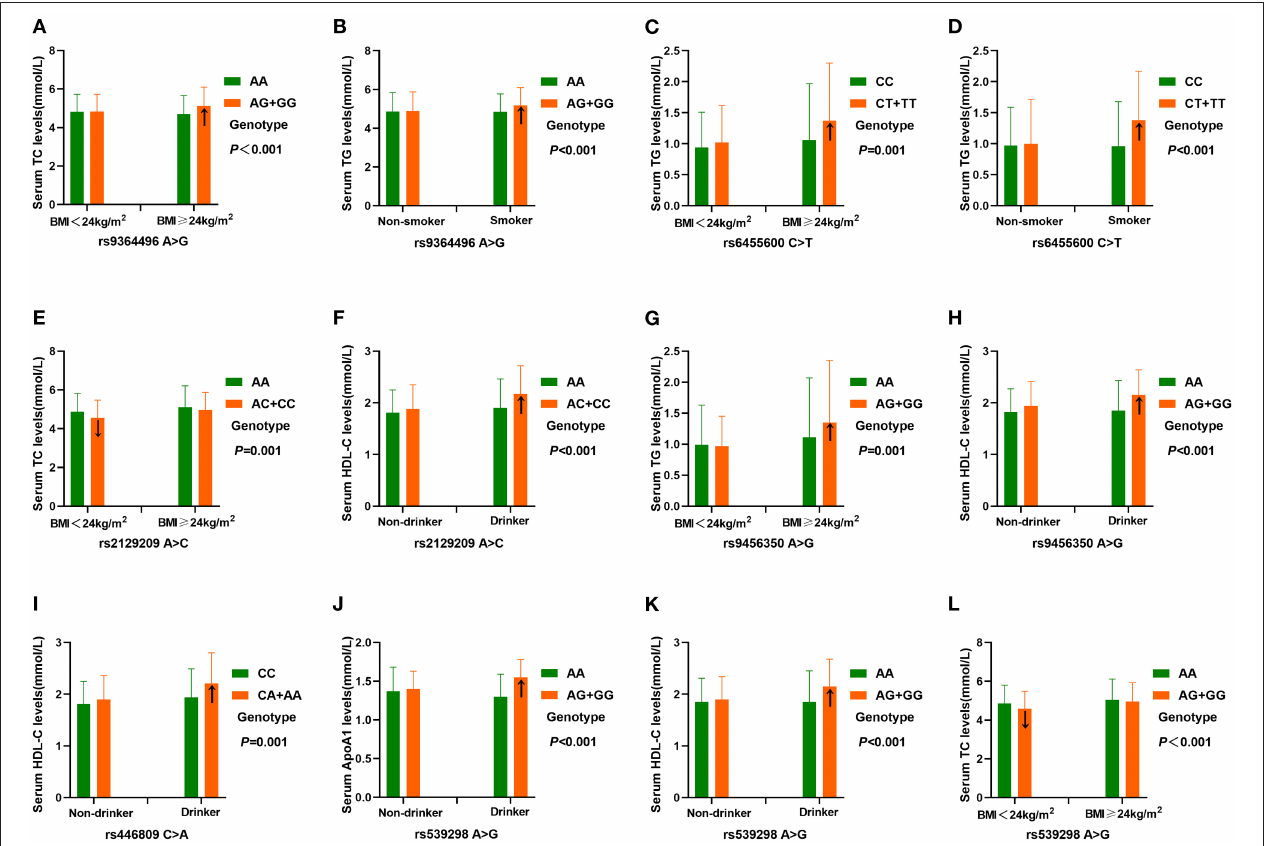
FIGURE 5 | The interactions of the SYTL3 - SLC22A3 SNPs and drinking, BMI and smoking on serum lipid levels. TC, total cholesterol; TG, triglyceride; BMI, body mass index; ApoA1, apolipoprotein A1; HDL-C, high-density lipoprotein cholesterol. A P ≤ 0.00125 (corresponding to P < 0.05 after adjusting for five environmental exposures multiplied by eight outcomes by the Bonferroni correction) was considered statistically significant. (A) , rs9364496-BMI on TC; (B) , rs9364496-smoking on TG; (C) , rs6455600-BMI on TG; (D) , rs6455600-smoking on TG; (E) , rs2129209-BMI on TC; (F) , rs2129209-drinking on HDL-C; (G) , rs9456350-BMI on TG; (H) , rs9456350-drinking on HDL-C; (I) , rs446809-drinking on HDL-C; (J) , rs539298-drinking on ApoA1; (K) , rs539298-drinking on HDL-C; (L) , rs539298-BMI on